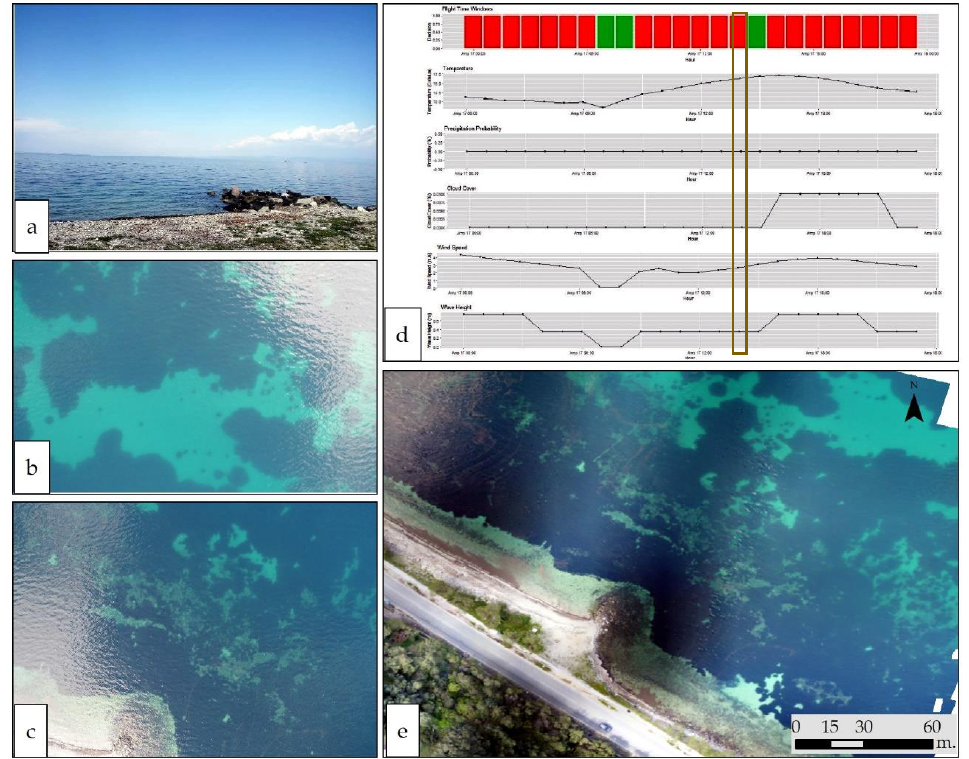
Figure 4. ( a ) view of the study area from a terrestrial image; ( b , c ) Nadir aerial images taken on